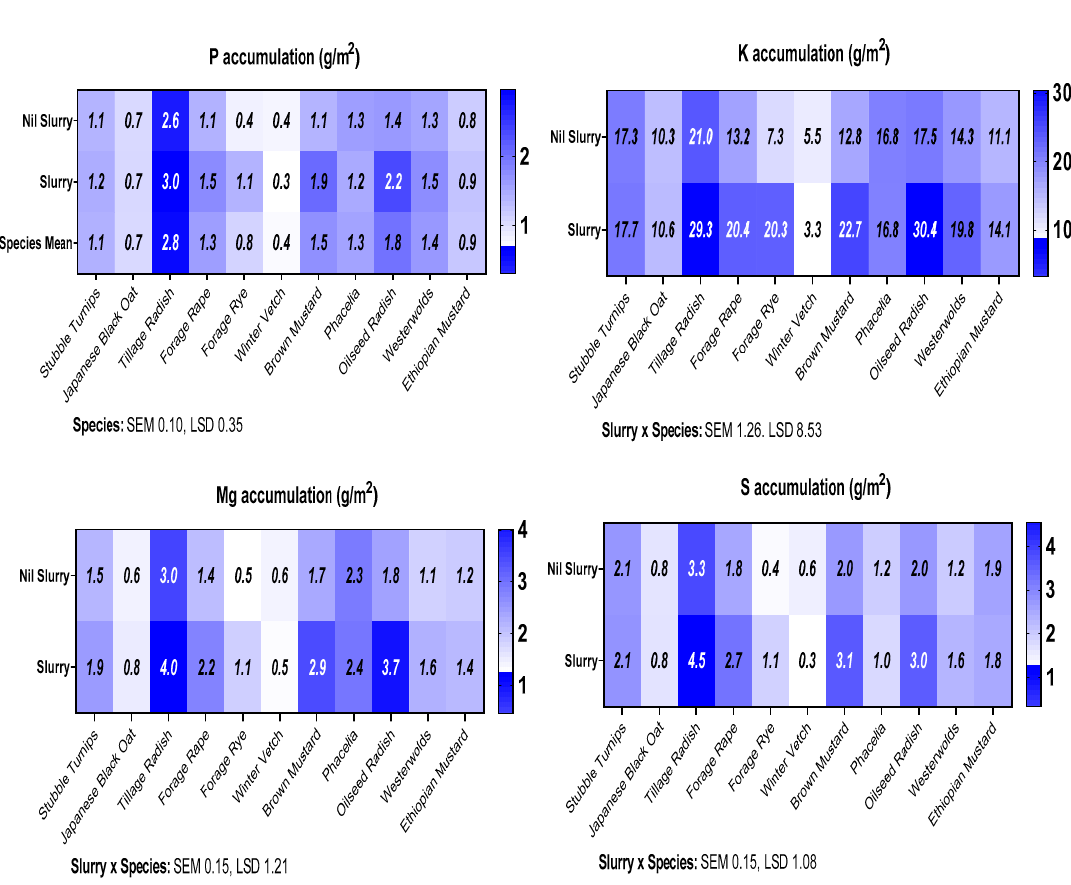
Figure 2. Species accumulation of P, K, Mg and S in response to slurry (g / m 2 ). N = 4 for each mean reported. Standard error of the mean (SEM) and the least significant di ff erence using Fisher’s post-hoc test (0.05) (LSD) are shown below each heat map for treatments that were found to be